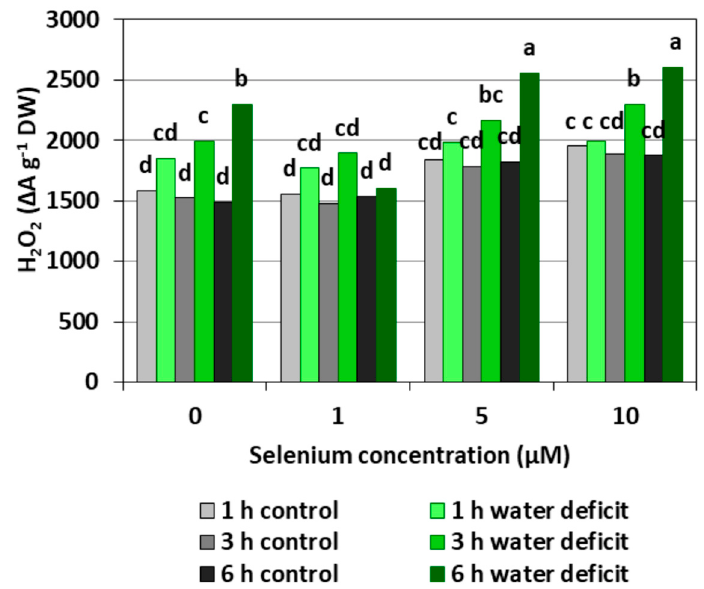
Figure 2. The hydrogen peroxide (H 2 O 2 ) level in the roots of cucumber seedlings pre-treated with Se and subjected to a WD. Bars marked with the same letters do not differ significantly at p < 0.05.